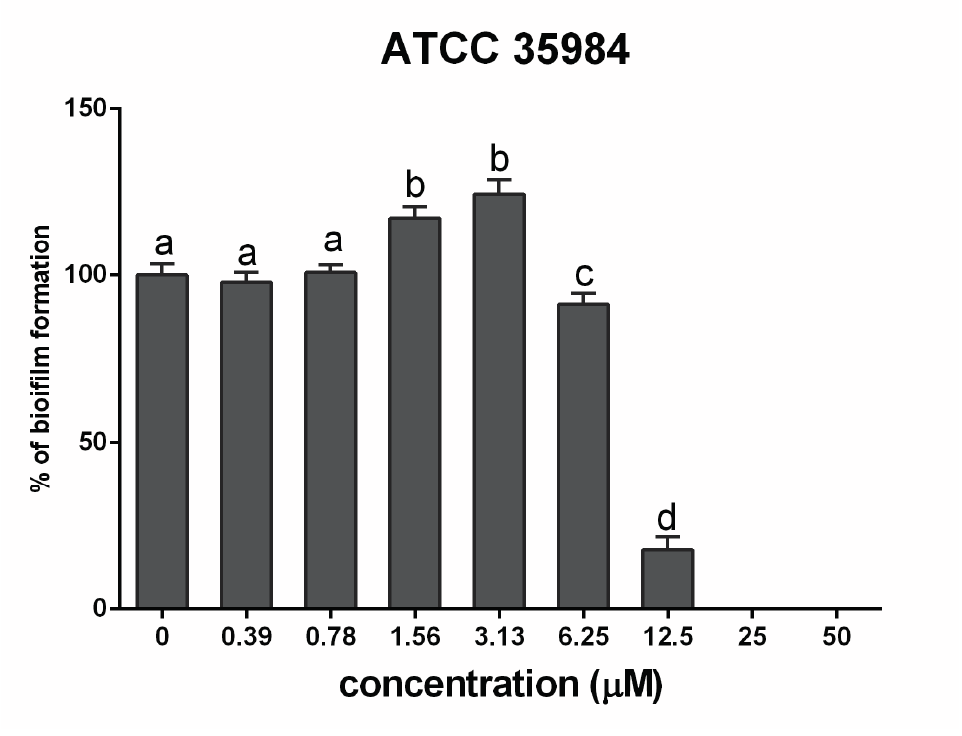
Figure 2. Mean (±SEM) percentage of biofilm formation by S. epidermidis (ATCC 35984) after exposure to different concentrations of cadmium. Different letters (a–d) indicate significant differences between compared treatment groups. MBIC was defined as the lowest concentration that inhibited at least 90% biofilm